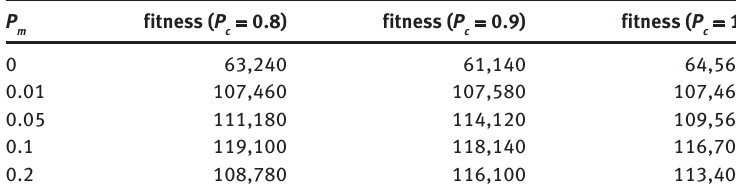
Table 3. Best Fitness of Different Combinations of Crossover and Mutation